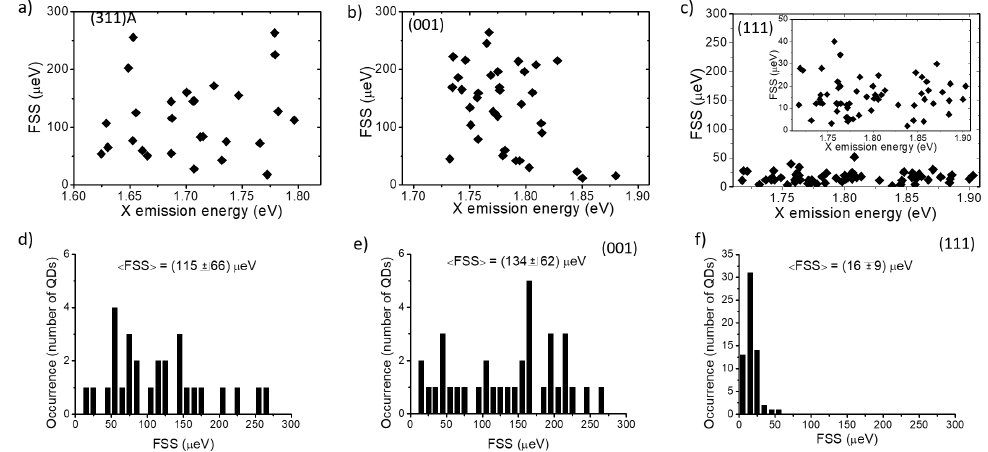
Figure 5. ( a ) Fine structure splitting (FSS) as a function of the X emission energy for (311)A QDs for the sample described in [69]. ( b ) Fine structure splitting as a function of the X emission energy for (001) QDs for the sample described in reference [71]. ( c ) Fine structure splitting as a function of the X emission energy for (111)A QDs. The insets show the same data rescaled for clarity. ( d – f ) Statistical distribution of the FSS corresponding to ( a – c ),